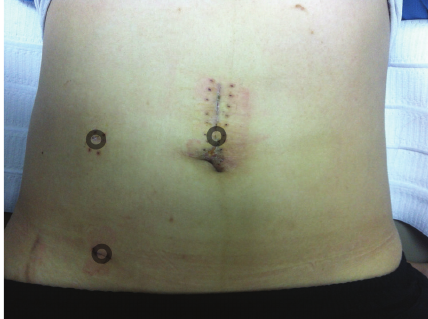
Figure 2: Trocar insertion sites. We used a 12mm supraumbilical port for the camera and two 5 mm ports (O: port insertion sites).